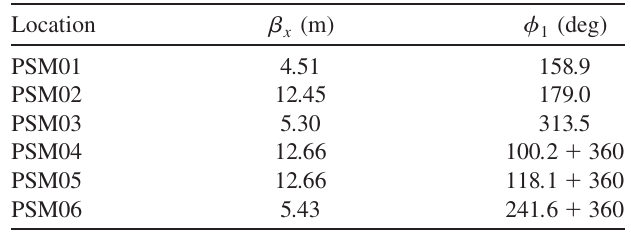
FIG. 5. (Color) A lattice configuration around the injection point at the PF ring. Six candidates for the PSM location are shown. The locations are free, straight sections. The labels B, Q, and S represent bending, quadrupole, and sextupole magnets, respec- tively. KM1–KM4 indicate kicker magnets for the pulsed bump injection. TABLE II. Horizontal betatron functions and phase angles at the candidate locations of the PSM.